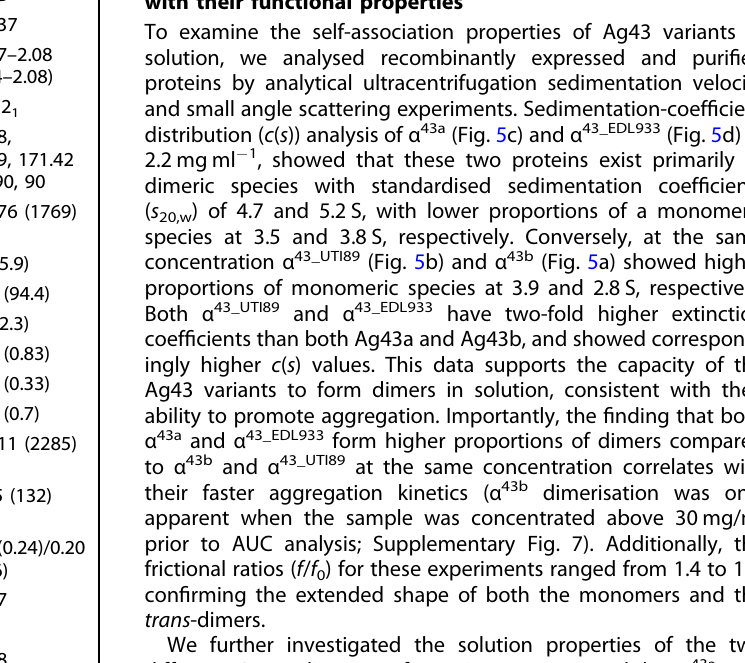
Table 1. X-ray crystallography data collection and statistics.